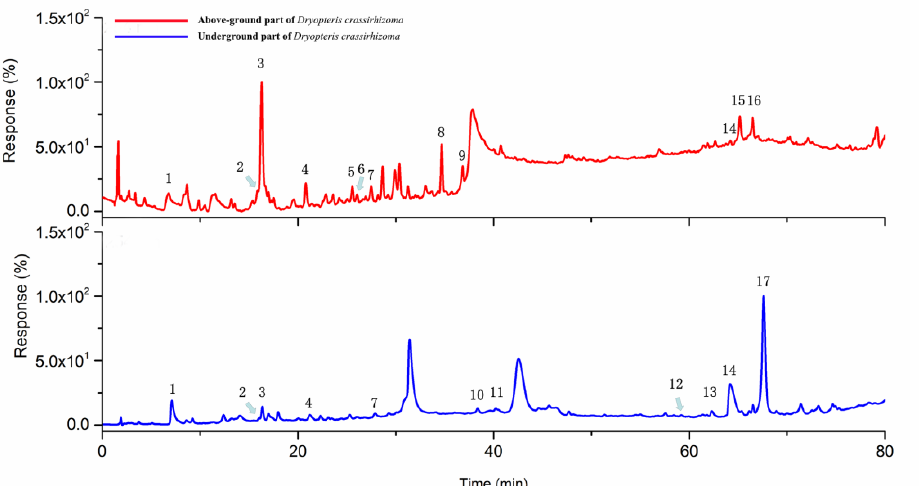
Figure 2. Nonvolatile components of the above-ground and underground of D. crassirhizoma deter- mined with UPLC-Q-TOF-MS.